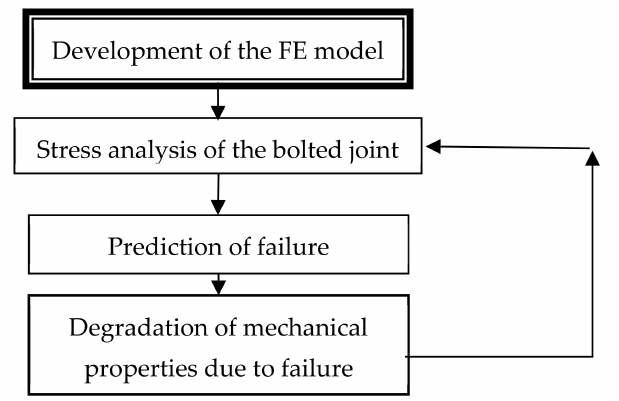
Figure 3. Iterative process of the PDM method.